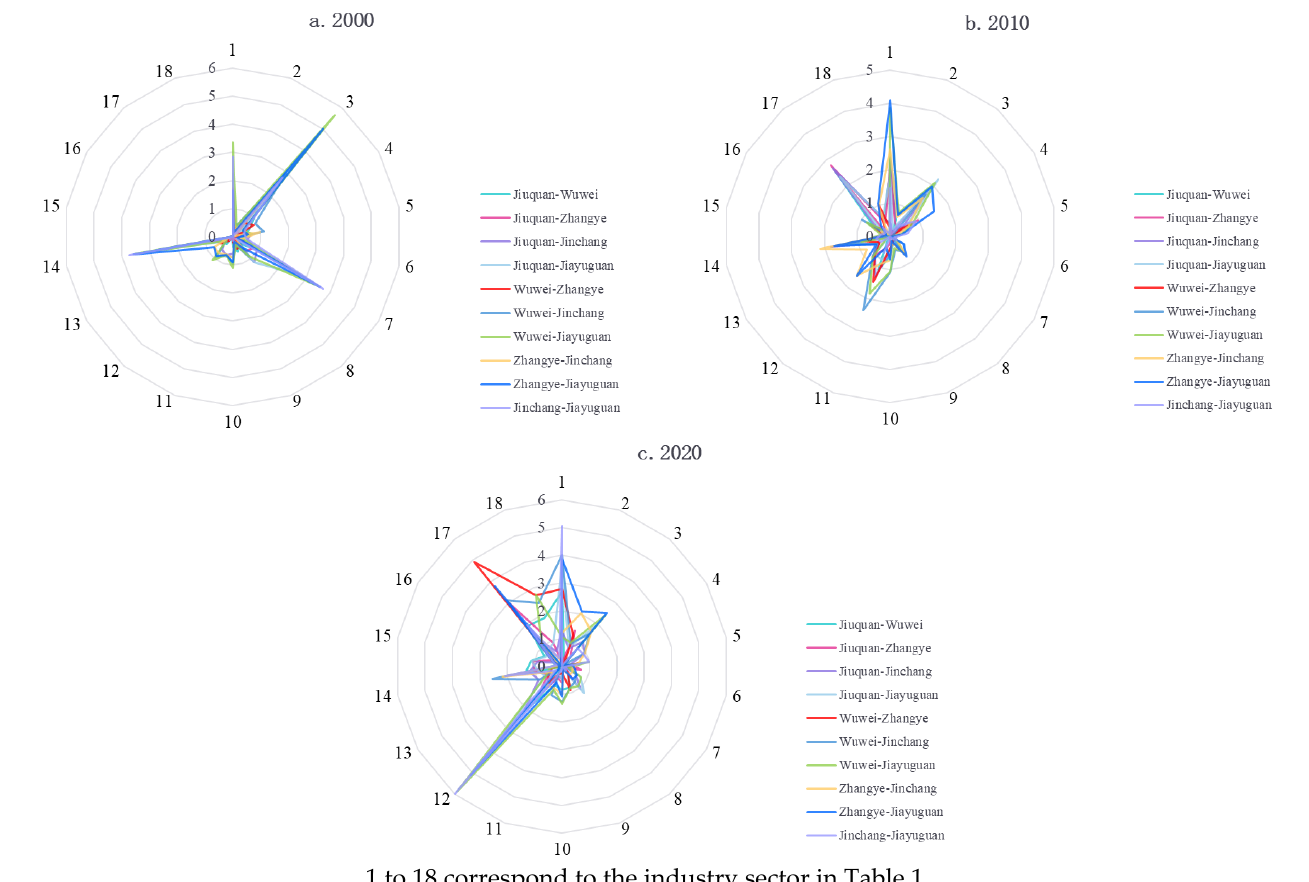
Figure 3. Industrial functional complementarity index in 2000, 2010, and 2020.